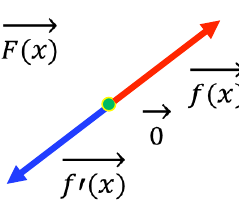
Figure 1. Vector function (cid:126) F ( x ) : [ − 1,1 ] −→ [ − 1,1 ] . The function is defined in Equation (4) and shown on Figure 2, where 2 1 = tanh ( x ) , which is uniformly continuous and defined on [ − 1, 1 ] . The limits ∀ x ∈ R , lim x →− ∞ tanh ( x ) = − 1 and lim x → + ∞ tanh ( x ) = 1. Thus, according to the continuous extension theorem, tanh ( x ) is continuous on [ − 1, 1 ] in Equation (4). Equations (1)–(3), respectively, describe the positive vector f ( x ) , the negative vector f (cid:48) ( x ) and the hyperbolic tangent F ( x ) . Each attribute x i of an object is described by a function F ( x i and its corre- sponding vector (Figure 1). If the attribute i is changing at each time t, the fuzzy value is calculated by the function F i , t ( x i , t ) , where i is the order number of the attribute in the object, x i , t is its value, and the scalar α i , t is the weight of the attribute in the object at each instant t. The weight in the object— α i , t or the function F i , t —could change over the time (for example, from linear to exponential, or to logarithmic) but it is rarely needed.